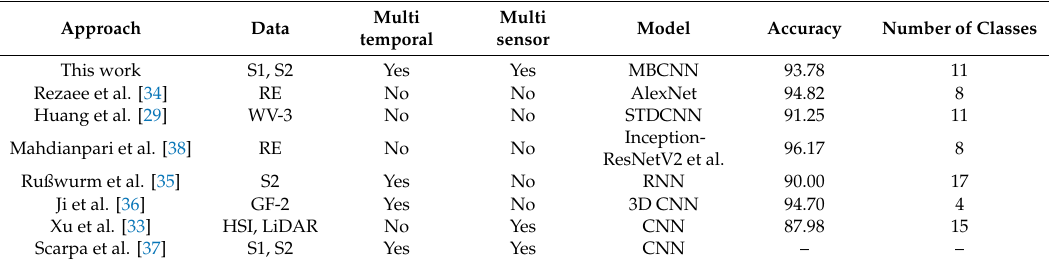
Table 9. Overview of recently published land cover / use classification